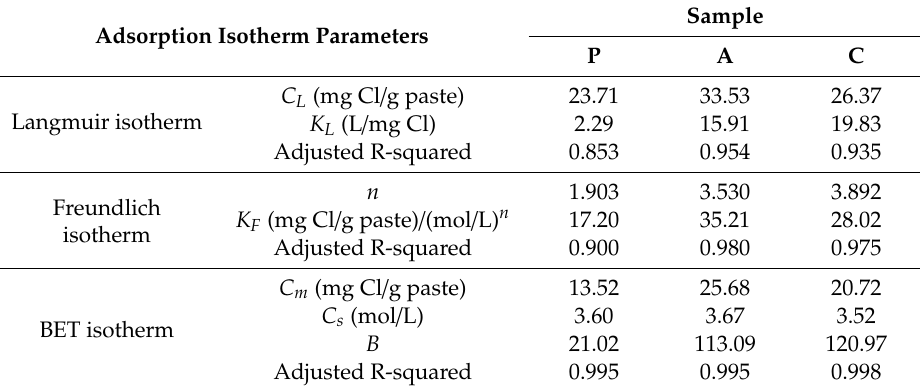
Table 4. Experimental parameters of the adsorption isotherm